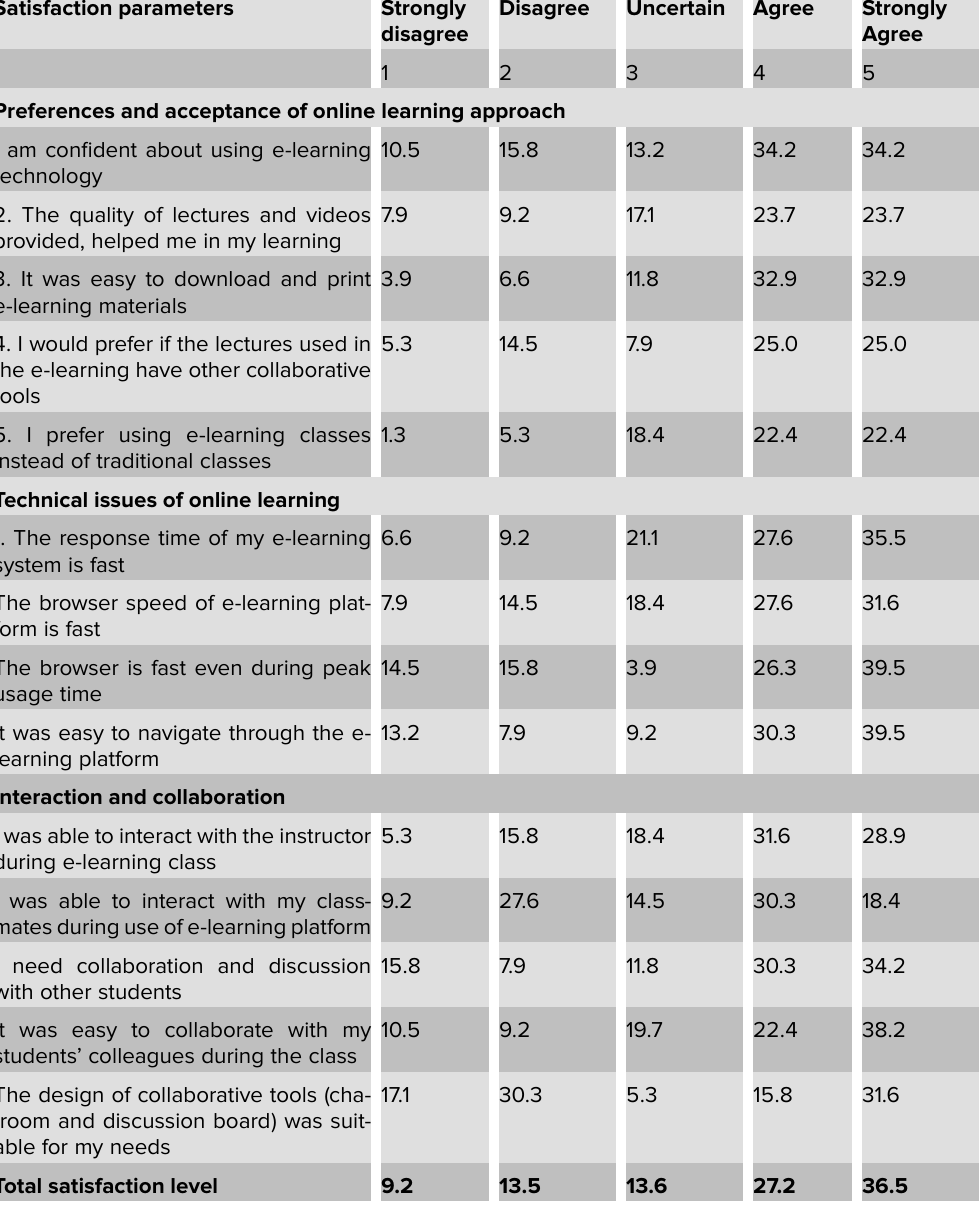
Table 2: Level of satisfaction of nursing students towards online learning during COVID-19, n = 76. Satisfaction parameters Strongly Disagree Uncertain Agree Strongly disagree